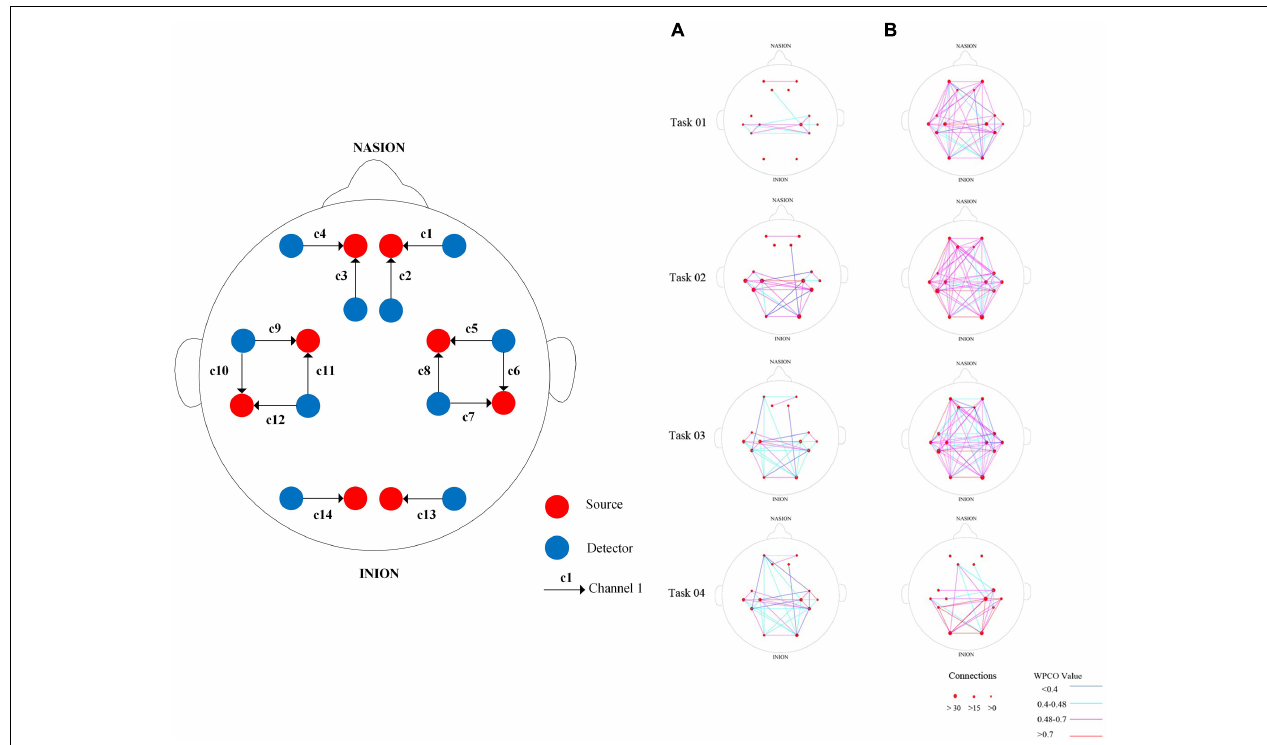
FIGURE 1 | Near-infrared channel probe layout (A) and typical examples of diagram of brain functional connectivity (FC) in interval I from the two groups. Arrangement of source optodes (red dots, S), detector optodes (blue dots, D), and measurement channels (black arrow, C) in the prefrontal cortex, motor cortex, and occipital leaf cortical areas based on the international 10/10 system. (B) Comparisons of wavelet phase coherence (WPCO) in the 15 connectivity types among the groups. (a) WPCO of MCI group in four states of interval I. (b) WPCO of control group in four states of interval I. Red lines represent WPCO values greater than 0.7. Pink lines represent WPCO values between 0.48 and 0.7. Light green lines represent WPCO values between 0.4 and 0.48. Blue lines represent WPCO values under 0.4. The size of the red dot at channel position represents the density of connection on this channel. The largest red dot means the number of connections on this channel is greater than 30; medium red dot, the number is between 0 and 15; smallest red dot, the number is 0–14. a, MCI group; b, healthy control (HC) group.